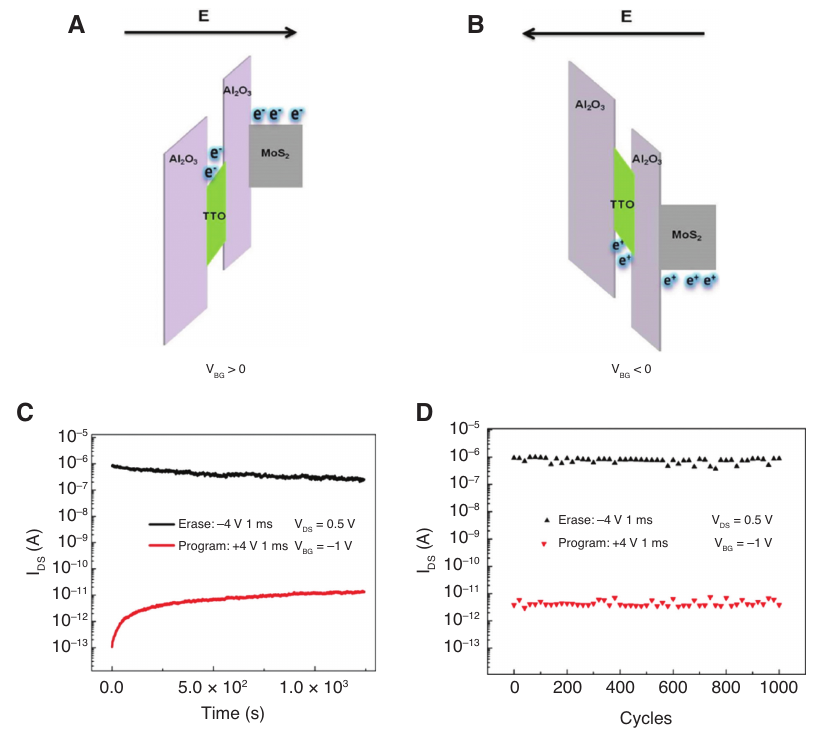
CTM device. Figure 3: Schematic band diagram and the reliability characterization of the MoS 2 > 0) and (B) erasing (V < 0) operations. Schematic band diagram and charge transport of the MoS CTM device in (A), programming (V 2 BG BG (C) Retention characteristics of the MoS CTM device with more than 10 4 on/off ratio after 10 4 -s retention time. (D) Endurance characteristics 2 of the MoS CTM device showing negligible degradation in memory window after 10 3 operation 2